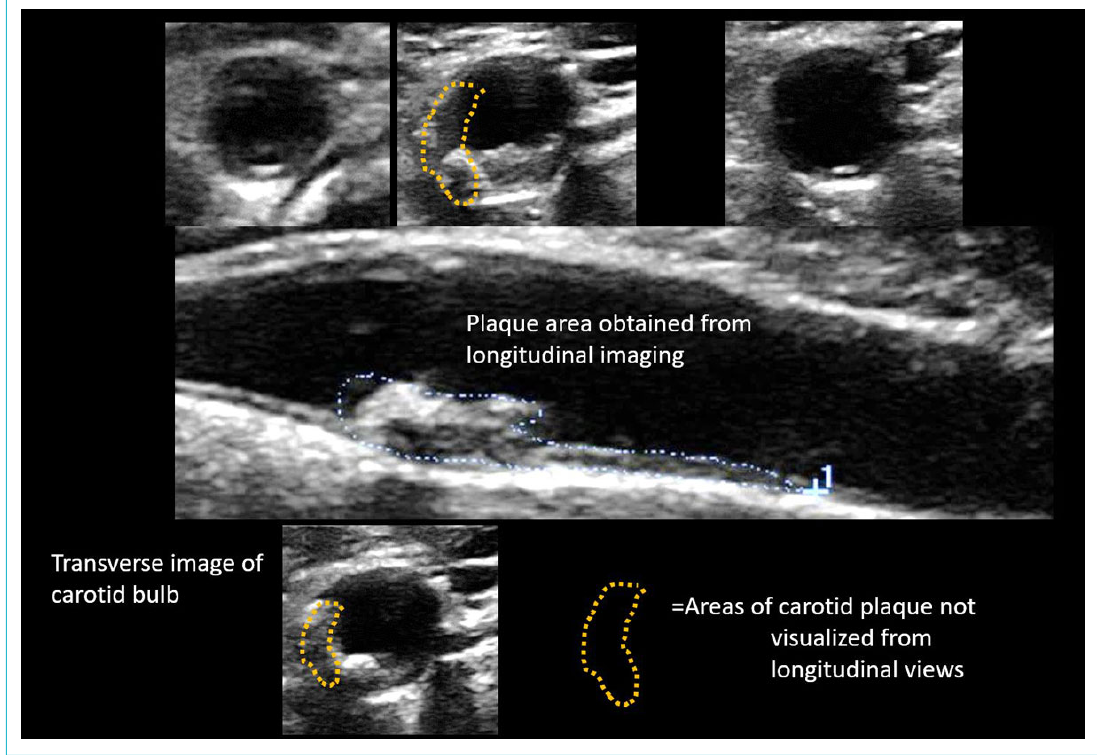
Figure 6: Large carotid plaque in the carotid bulb, which contains plaque formation not visible in the longitudinal